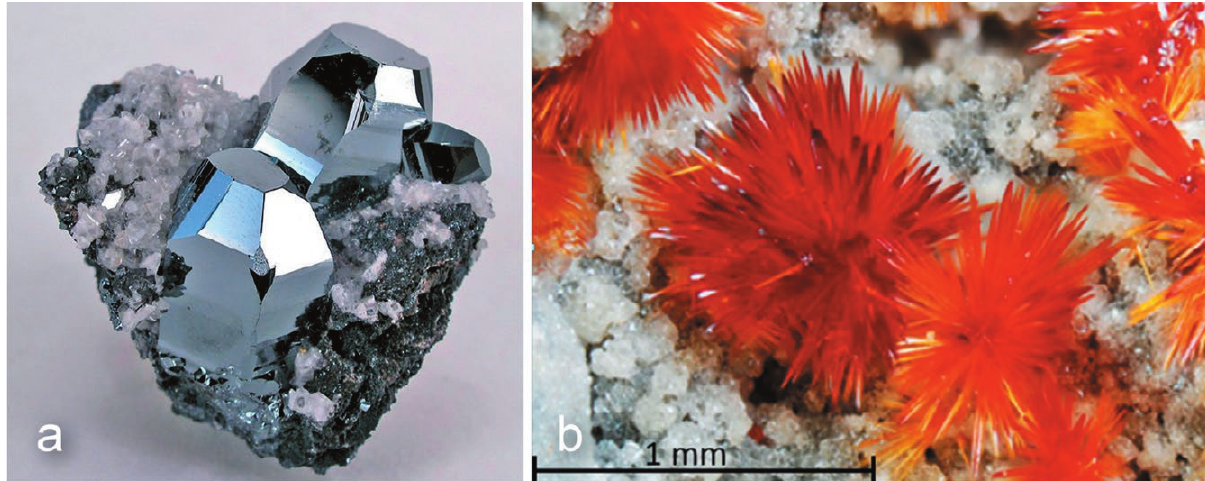
Fig. 1. Morphology and colour of minerals. 1a: Hematite Fe2O3 (https://www.mindat.org/photo-122270.html). 1b: Red and yellow crystals of cetineite [(K,Na)6Sb3+12(Sb3+S3)2O18(OH)0.5.5H2O] (Collection V. Paoletti, photo by B. Fassina, published with